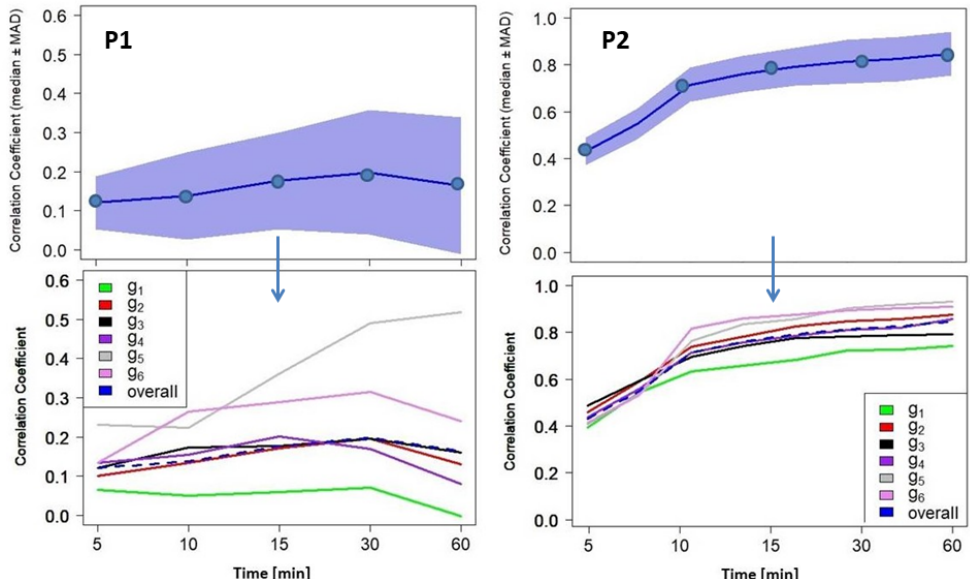
Figure 11. Median correlation coefficients among all stations ( upper panels ) and within groups ( lower panels ), for the two normalization procedures: P1 and P2. Upper panels : The reported bands correspond to the median absolute deviation (MAD). Lower panel : The dashed lines are the median correlations among all stations (taken from the corresponding upper panels ) and are included for comparison